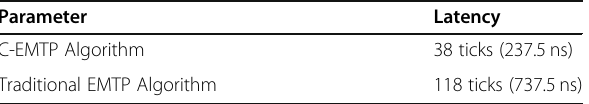
Table 3 Time latency of simulation algorithm